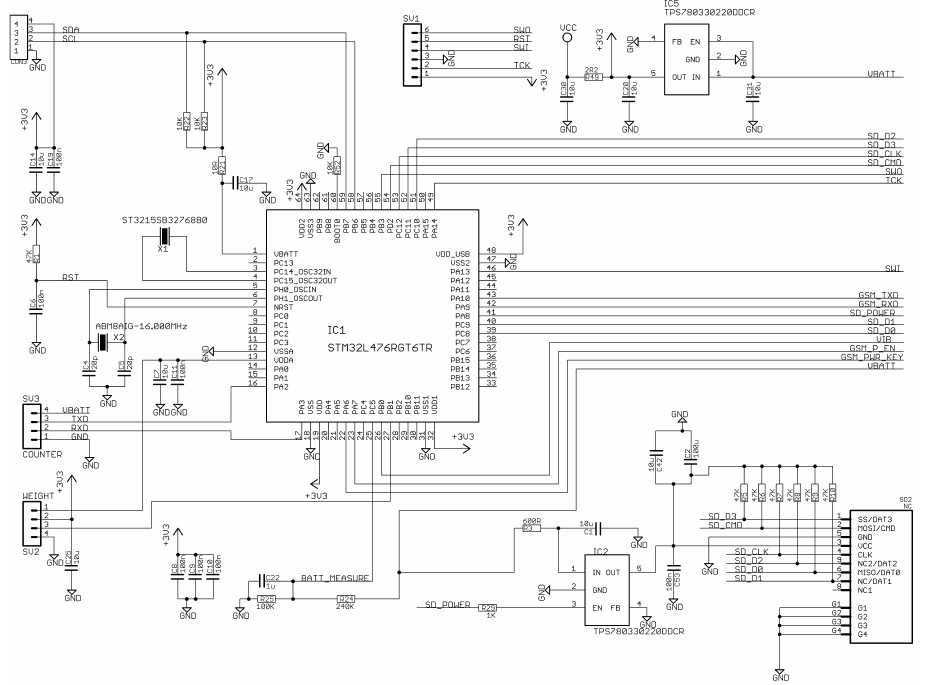
Figure A4. The schematic diagram of the main board of the system. It is based on the STM32L476RG microcontroller of the ST. The system is powered by a battery and the voltage stabilization at 3.3V